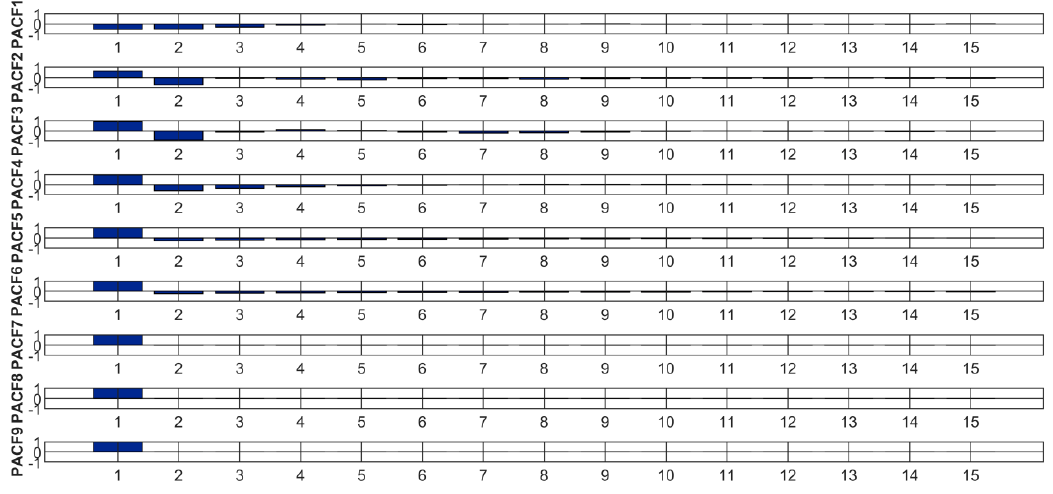
Figure 10. The PCAF results of the Hubei carbon price after EEMD. Table 5. The PACF results of the Hubei carbon price.